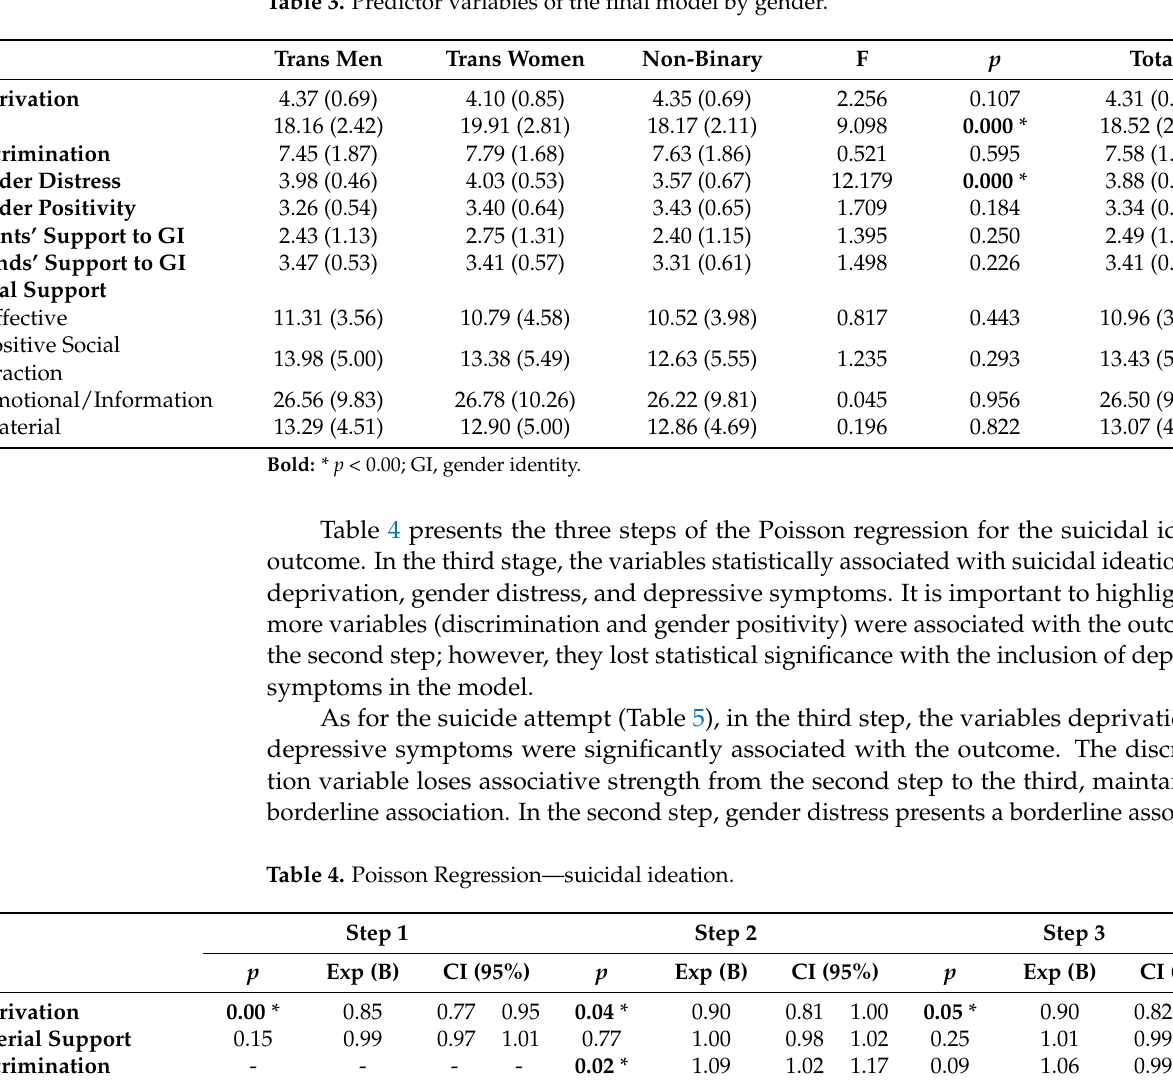
Table 3. Predictor variables of the final model by gender.